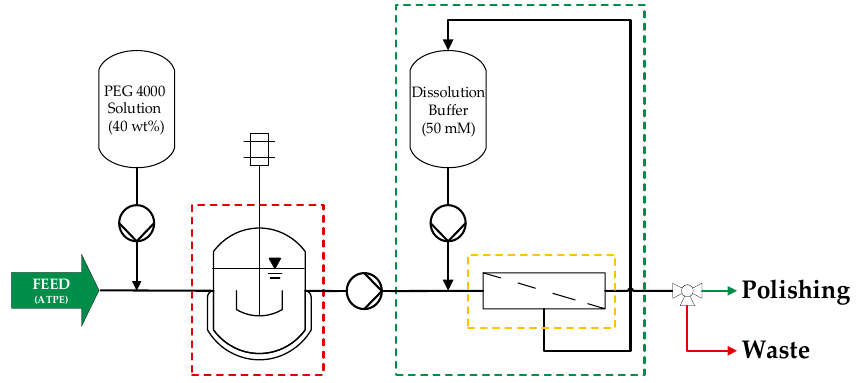
Figure 3. Representation of the areas that were used for the material balance in the developed process model. Red represents the balance room for precipitation, yellow for filtration and green for dissolution.